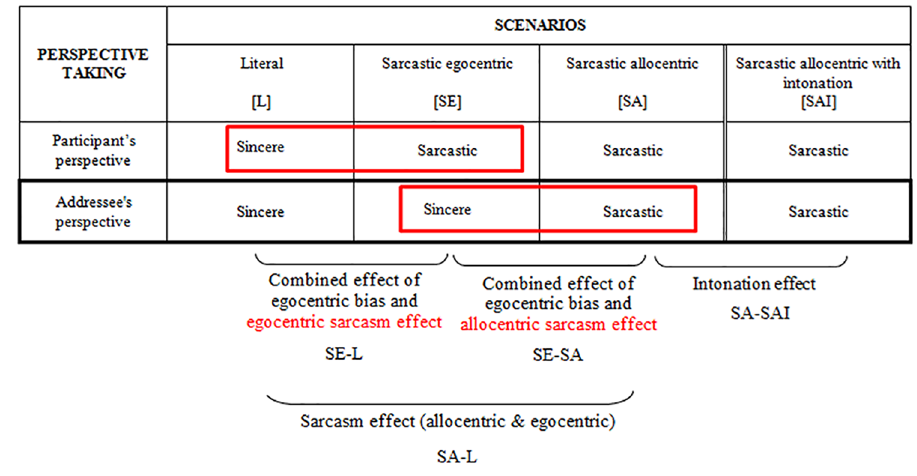
Fig 3. Sarcasm Detection